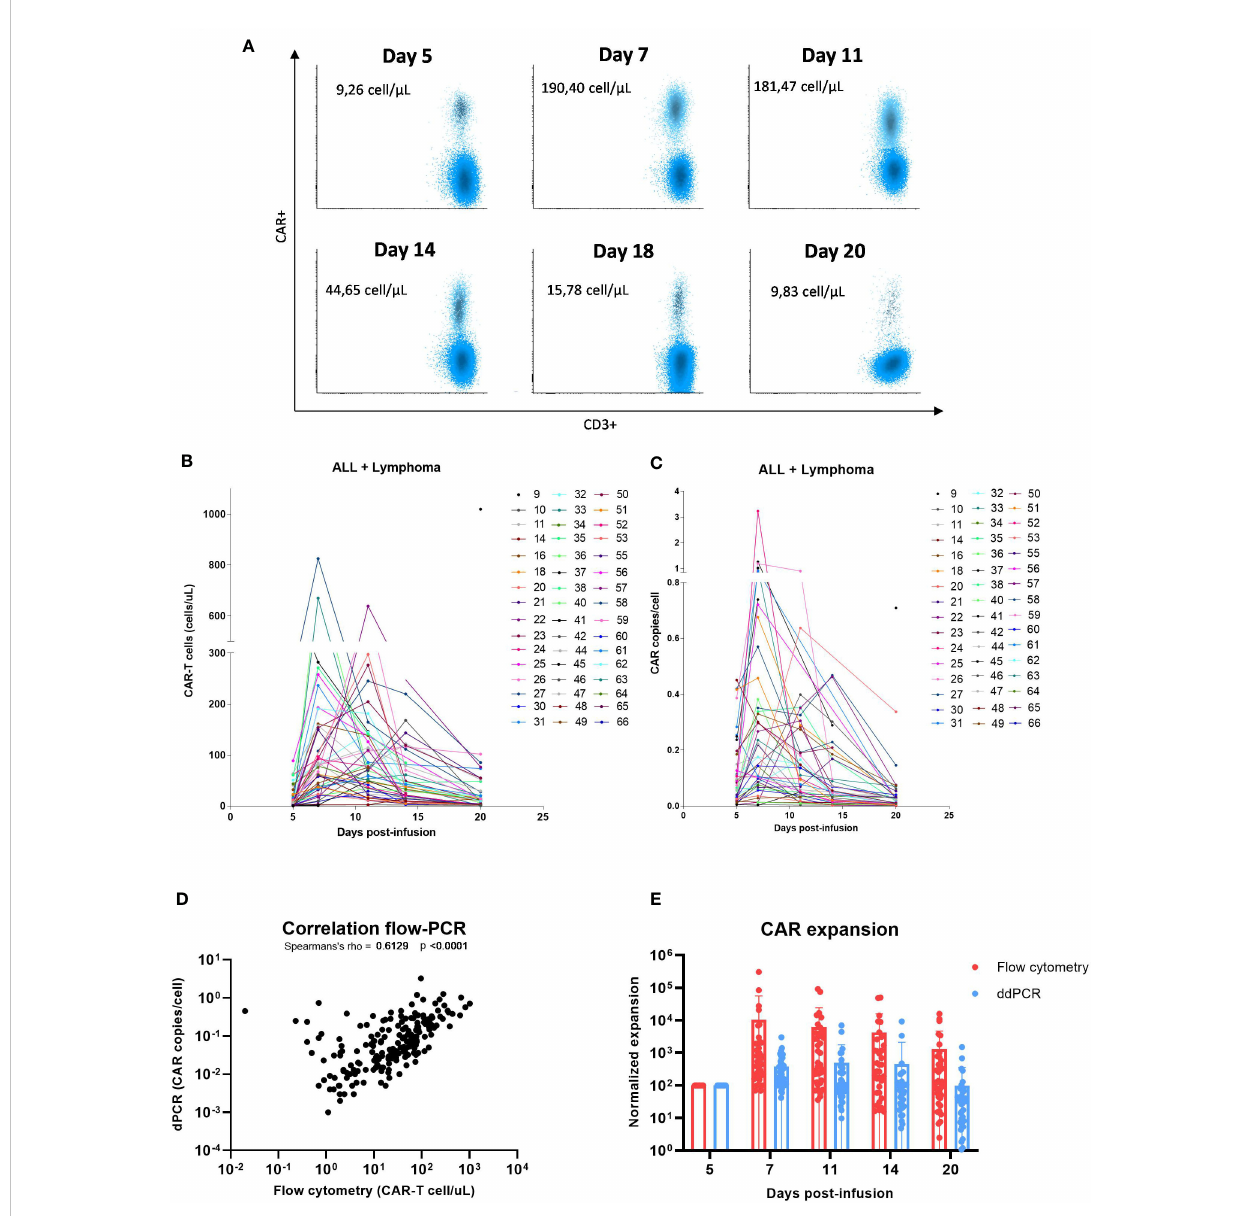
FIGURE 2 Commercial CD19 CAR-T cell expansion in the blood of patients post-infusion. (A) Flow cytometry plot of the expansion of CAR-T cells in the blood of patient 32 at different time points post-infusion. (B) Absolute count of CAR-T cells/uL by fl ow cytometry in the blood of patients with B-ALL and lymphoma. (C) CAR copies/cell measured by digital PCR in the blood of patients with B-ALL and lymphoma. (D) Spearman correlation in peripheral CAR-T cell expansion between fl ow cytometry and dPCR assays (n=48 patients and 185 observations). (E) Normalized peripheral CAR-T cell expansion by fl ow cytometry and dPCR assays (n=48 patients). Correlation was calculated using non-parametric Spearmans rank correlation coef fi